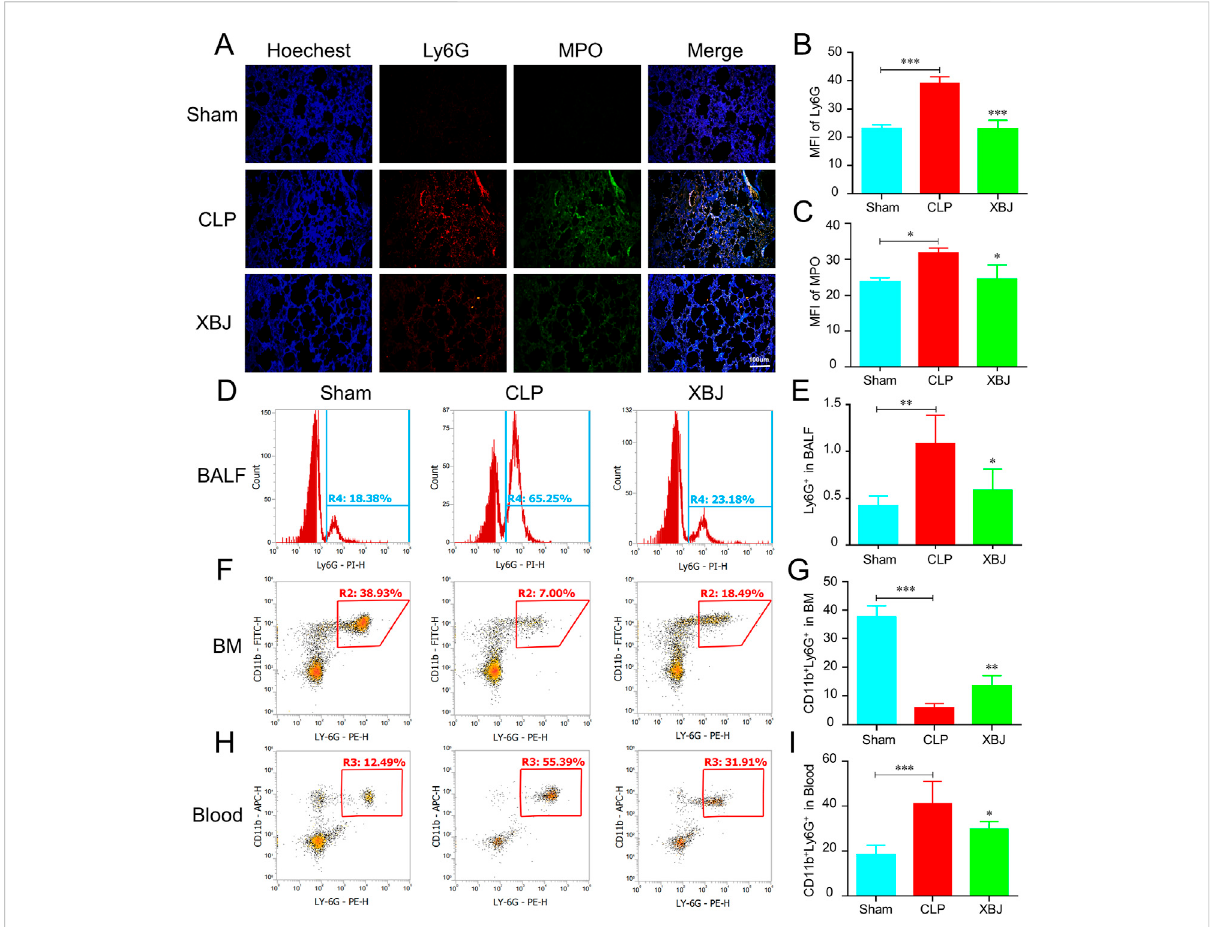
FIGURE 2 XBJ reduced the neutrophil recruitment to lung tissues in sepsis (A) . The confocal microscope images of Ly6G (red), MPO (myeloperoxidase, green) and nuclei (blue) staining in lung sections (B,C) . The quanti fi cation of Ly6G (B) and MPO (C) expression ( n = 4) (D,E) . The Ly6G positive cells in bronchoalveolar lavage fl uid (BALF) in different groups were analyzed with fl ow cytometry (F,G) . The neutrophil counts in bone marrow of septic miceweredeterminedby fl owcytometryusinganti-CD11bandanti-Ly6Gantibodies (H,I) .ThepercentagesofCD11bandLy6Gdoublepositive neutrophils in the peripheral blood of different groups of mice, which were determined with fl ow cytometry analysis. N = 5/per group. The values were indicated as mean ± SD. * p < 0.05, ** p < 0.01, compared with the CLP